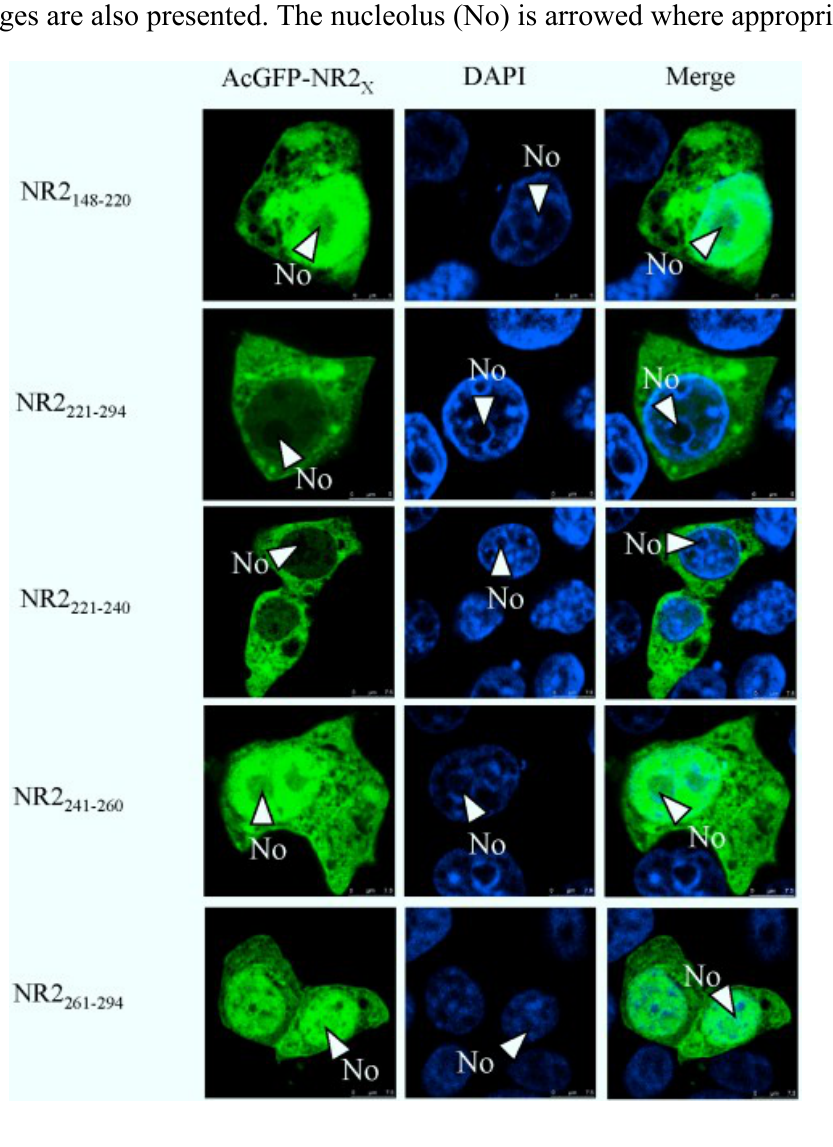
Figure 7. Confocal microscopy of the sub-cellular localization of fluorescent fusion proteins: AcGFP-NR2 , AcGFP-NR2 AcGFP-NR2 , AcGFP-NR2 , 148–220 221–294 221–240 241–260 and AcGFP-NR2 . Fusion proteins are colored green and nucleus colored 261–294